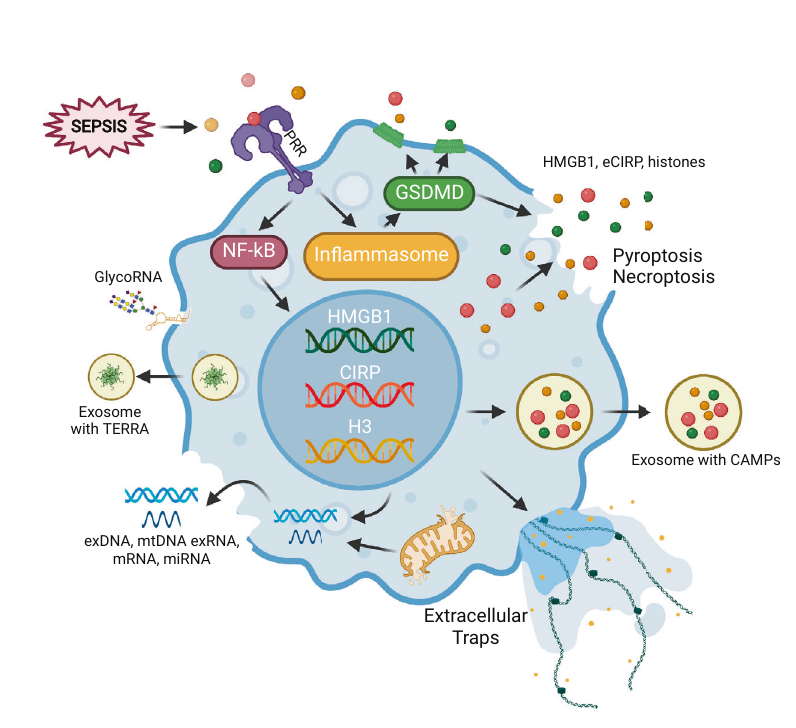
Fig. 1 Release of CAMPs in sepsis. Septic insults, PAMPs, and other noxious stimuli activate immune cells (macrophages) to increase the expression and release of CAMPs, i.e., nuclear and mitochondrial DNAs, histones, RNAs, miRNAs, extracellular traps, HMGB1, and eCIRP. CAMPs are released through active processes like exosomes and GSDMD-mediated pores and passive release mechanisms like pyroptosis, necroptosis, ETosis, and secondary necrosis. PRR Pattern recognition receptor, GSDMD Gasdermin D, HMGB1 High mobility group box 1, eCIRP extracellular CIRP, CAMPs chromatin-associated molecular patterns, exDNA extracellular DNA, mtDNA Mitochondrial DNA, TERRA Telomeric repeat-containing